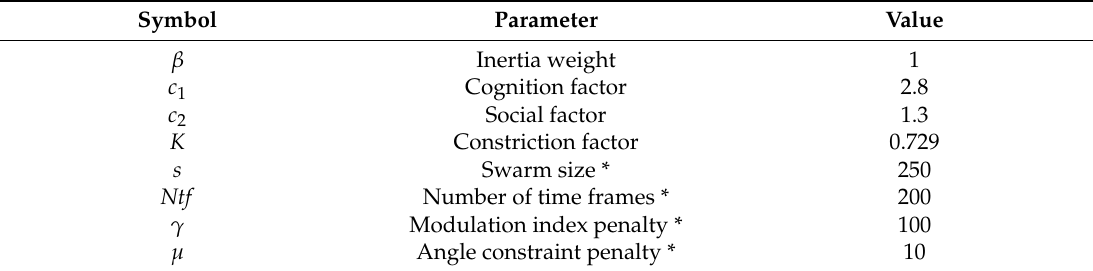
Figure 6. Fitness values expressed as decadic logarithmic error against the number of time frames. Table 2. Optimized Parameters of PSO Algorithm (optimized parameters are marked by *, and others are default parameters).